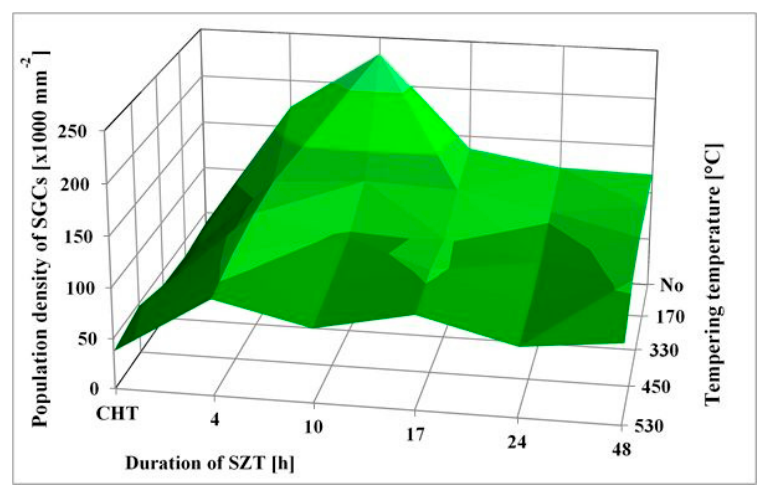
Figure 3. Population density of small globular carbides for differently sub-zero treated (at − 75 °C) and tempered specimens.